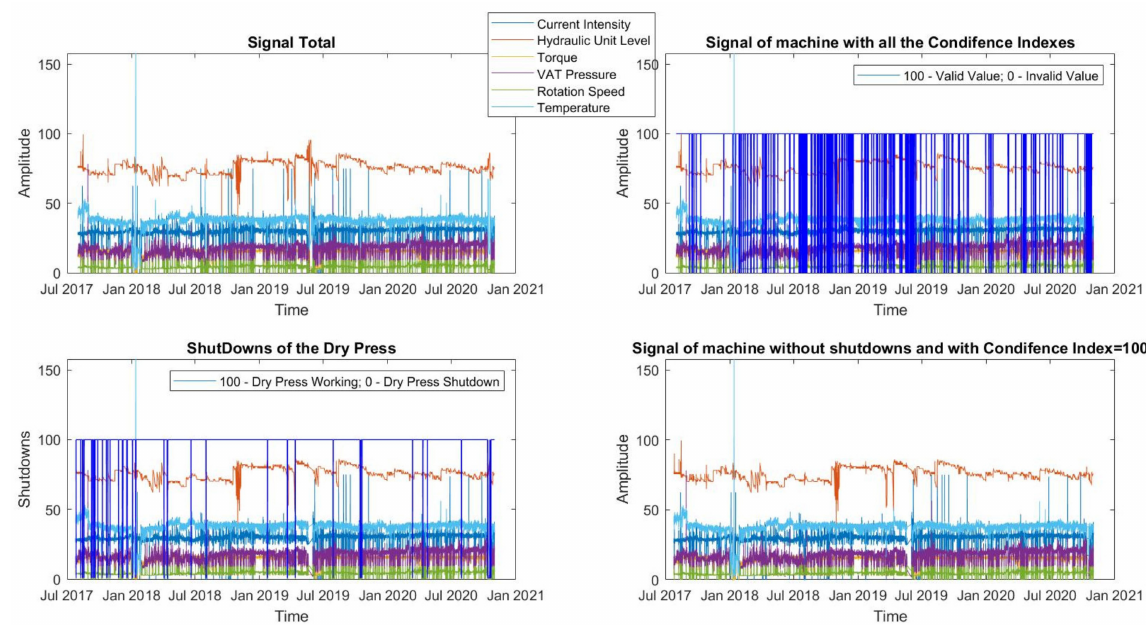
Figure 2. Data cleaning of the signals with through Confidence Indexes and shutdowns of the